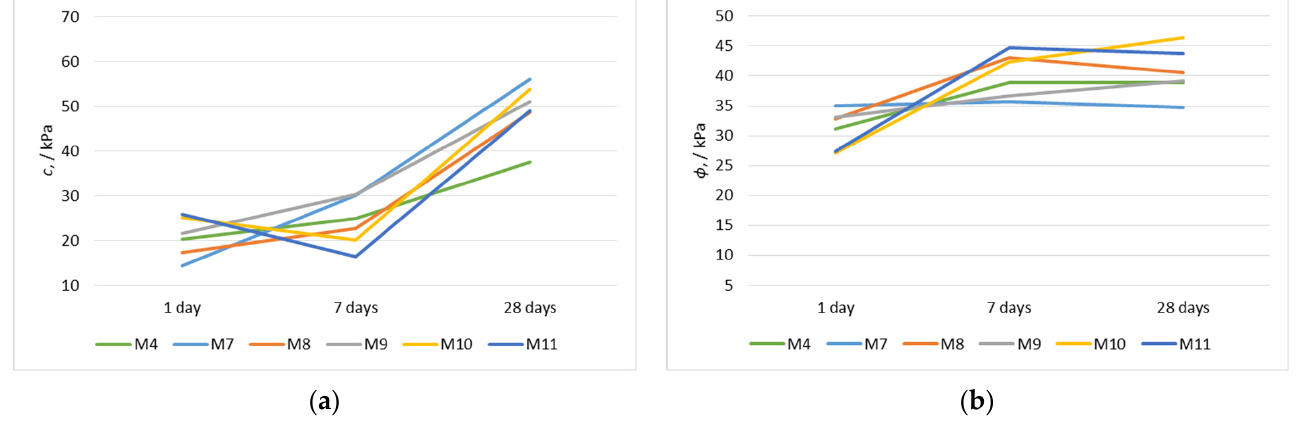
Figure 13. Cohesion and internal friction angle values change with specimen age, samples M4 and